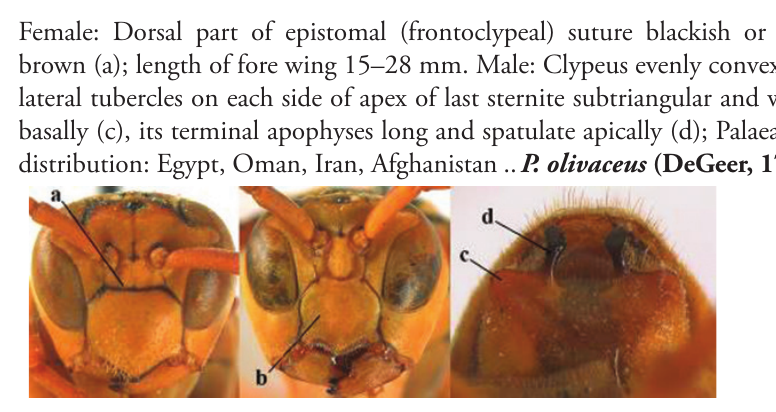
– Female: Dorsal part of epistomal suture yellowish (aa); length of fore wing 11– 17 mm. Male: Clypeus with impression (bb); lateral tubercles of last sternite more cylindrical and narrower basally (cc), its terminal apophyses long and pointed apically (dd); Palaearctic distribution: Afghanistan, Iran, Iraq, Saudi Arabia, United Arab Emirates, Oman, China ........... P. wattii Cameron, 1900